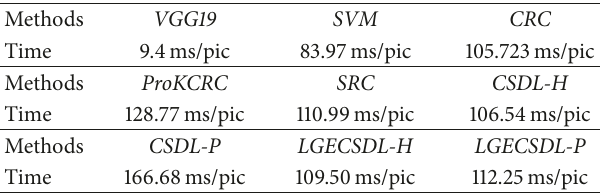
Table 4: Computational time of each method in Caltech101.